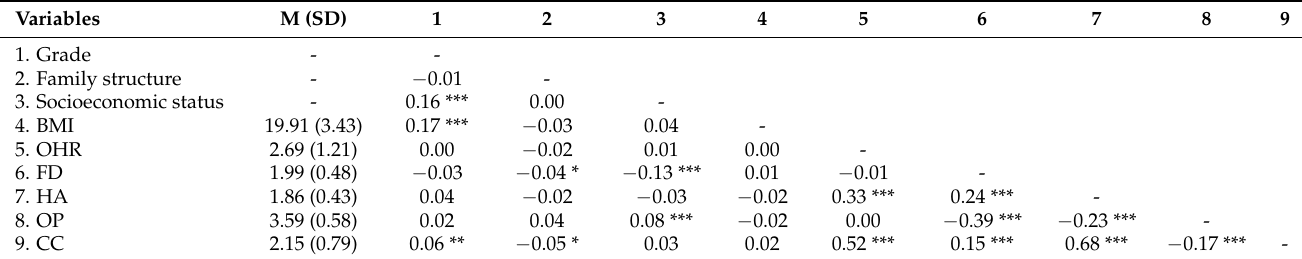
Table 2. Descriptive statistics and between-variable